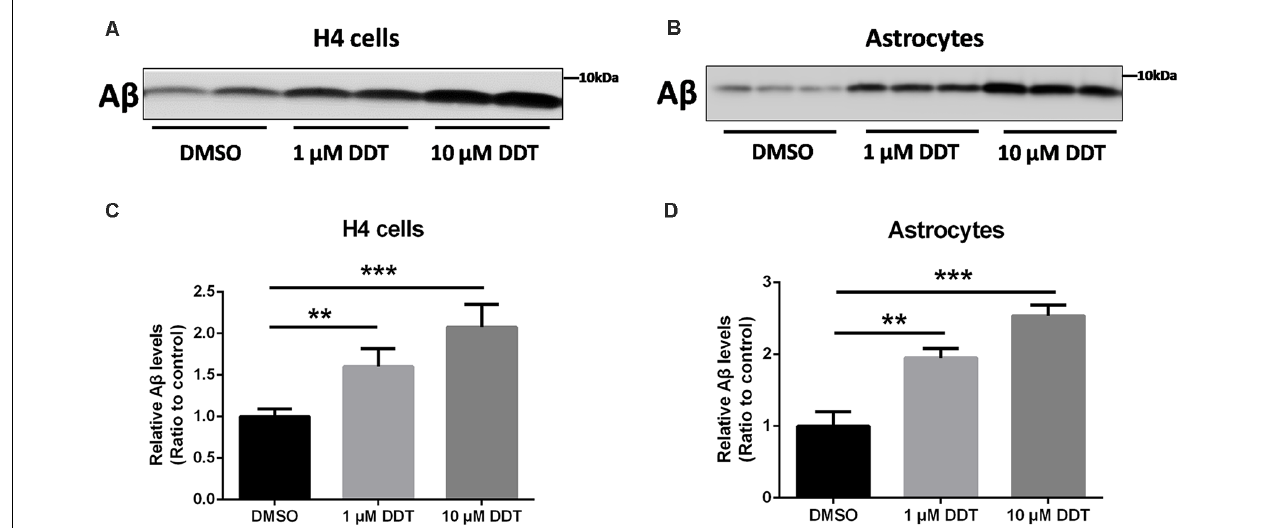
FIGURE 2 | DDT decreases amyloid beta (A β ) clearance in H4 human neuroglioma cells and immortalized astrocytes. (A) The remaining A β in H4 human neuroglioma cells media; (B) the remaining A β in immortalized astrocytes media; (C) semiquantitative analysis of A β in H4 human neuroglioma cells media; (D) semiquantitative analysis of A β in immortalized astrocytes media. Mean ± SEM, n = 6, ** P < 0.01 vs. control, *** P < 0.001 vs. dimethyl sulfoxide (DMSO) control group.